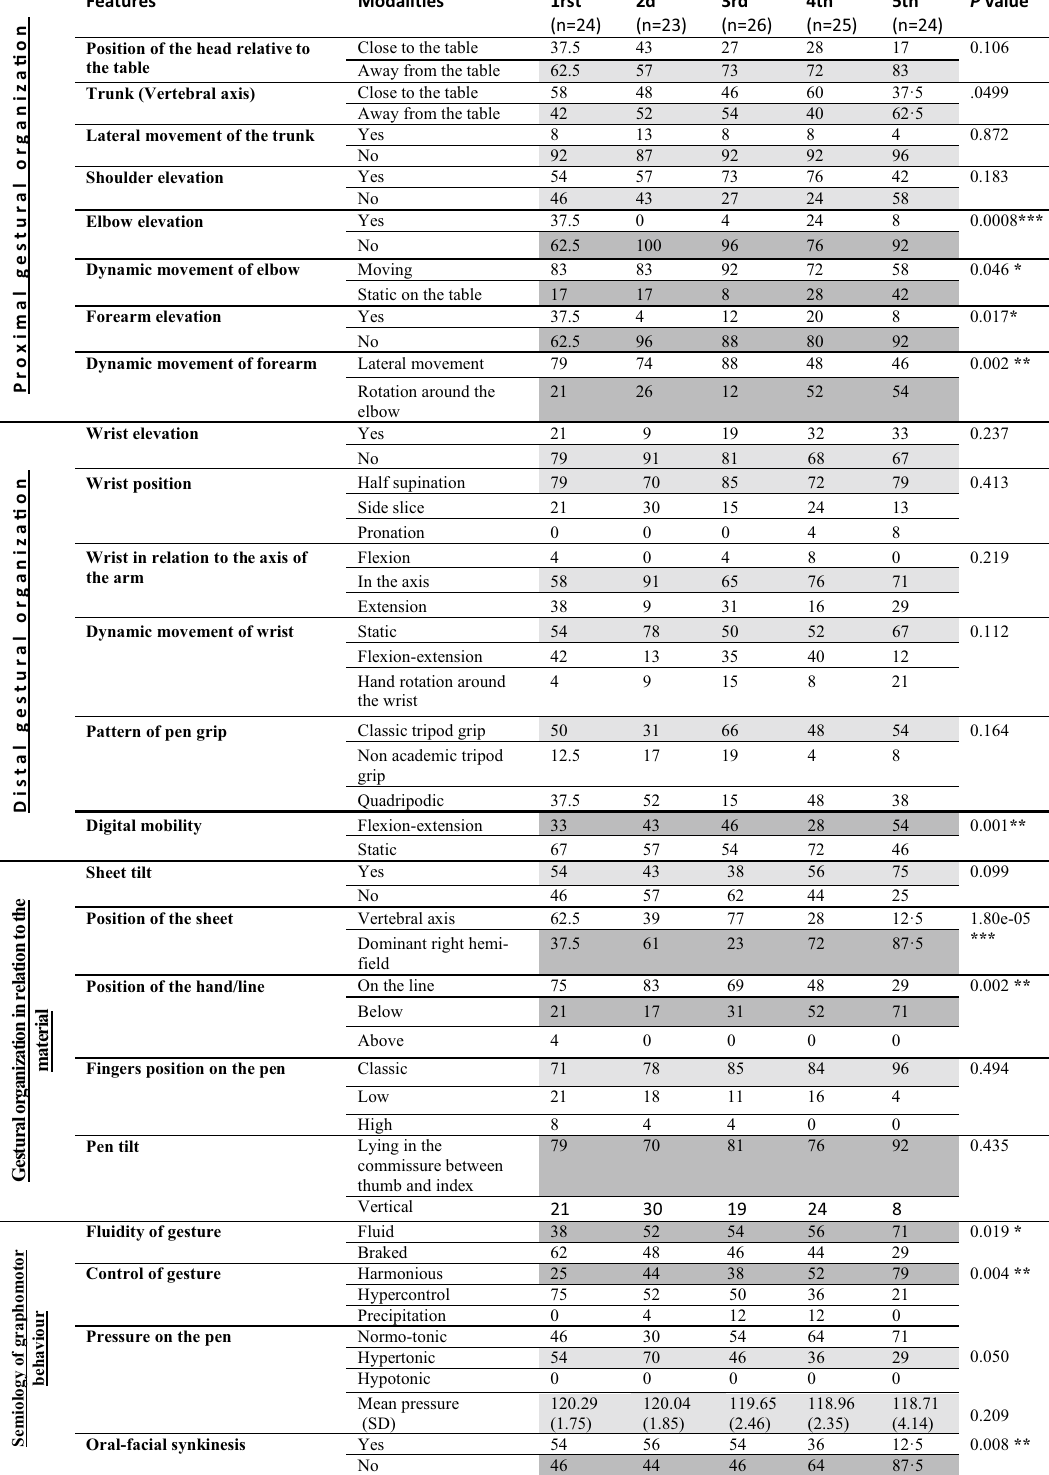
Table 2. Distribution of the modalities of postural and gestural features according to the grade level (%) in sample 2 (N = 122) for the copy of a line of cycloid loops. *p < 0.05; **p < 0.01; ***p < 0.001. Shaded